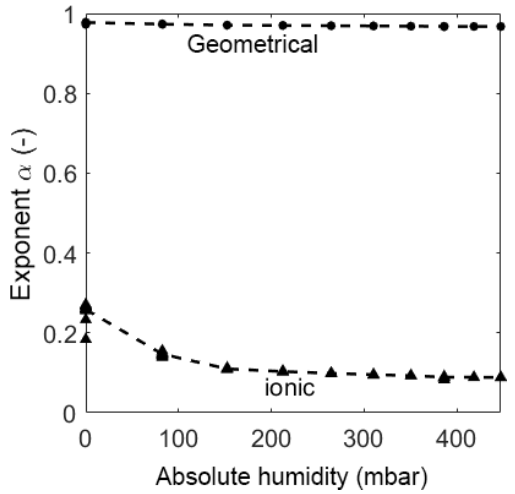
Figure 9. Prefactor of CPE geo over relative humidity at room tem- perature. The dots represent the value of the fit of each measure- ment. The dashed line represents the mean of the dots.